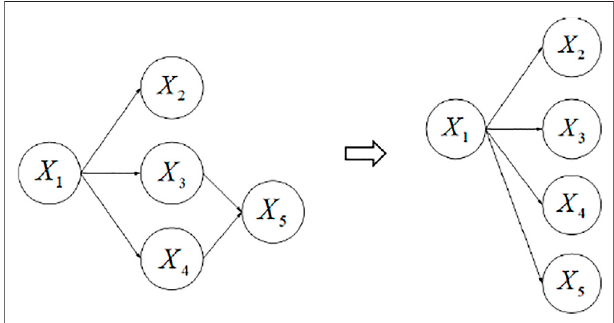
FIGURE 4 | Simpli fi ed schematic diagram of a Bayesian network.